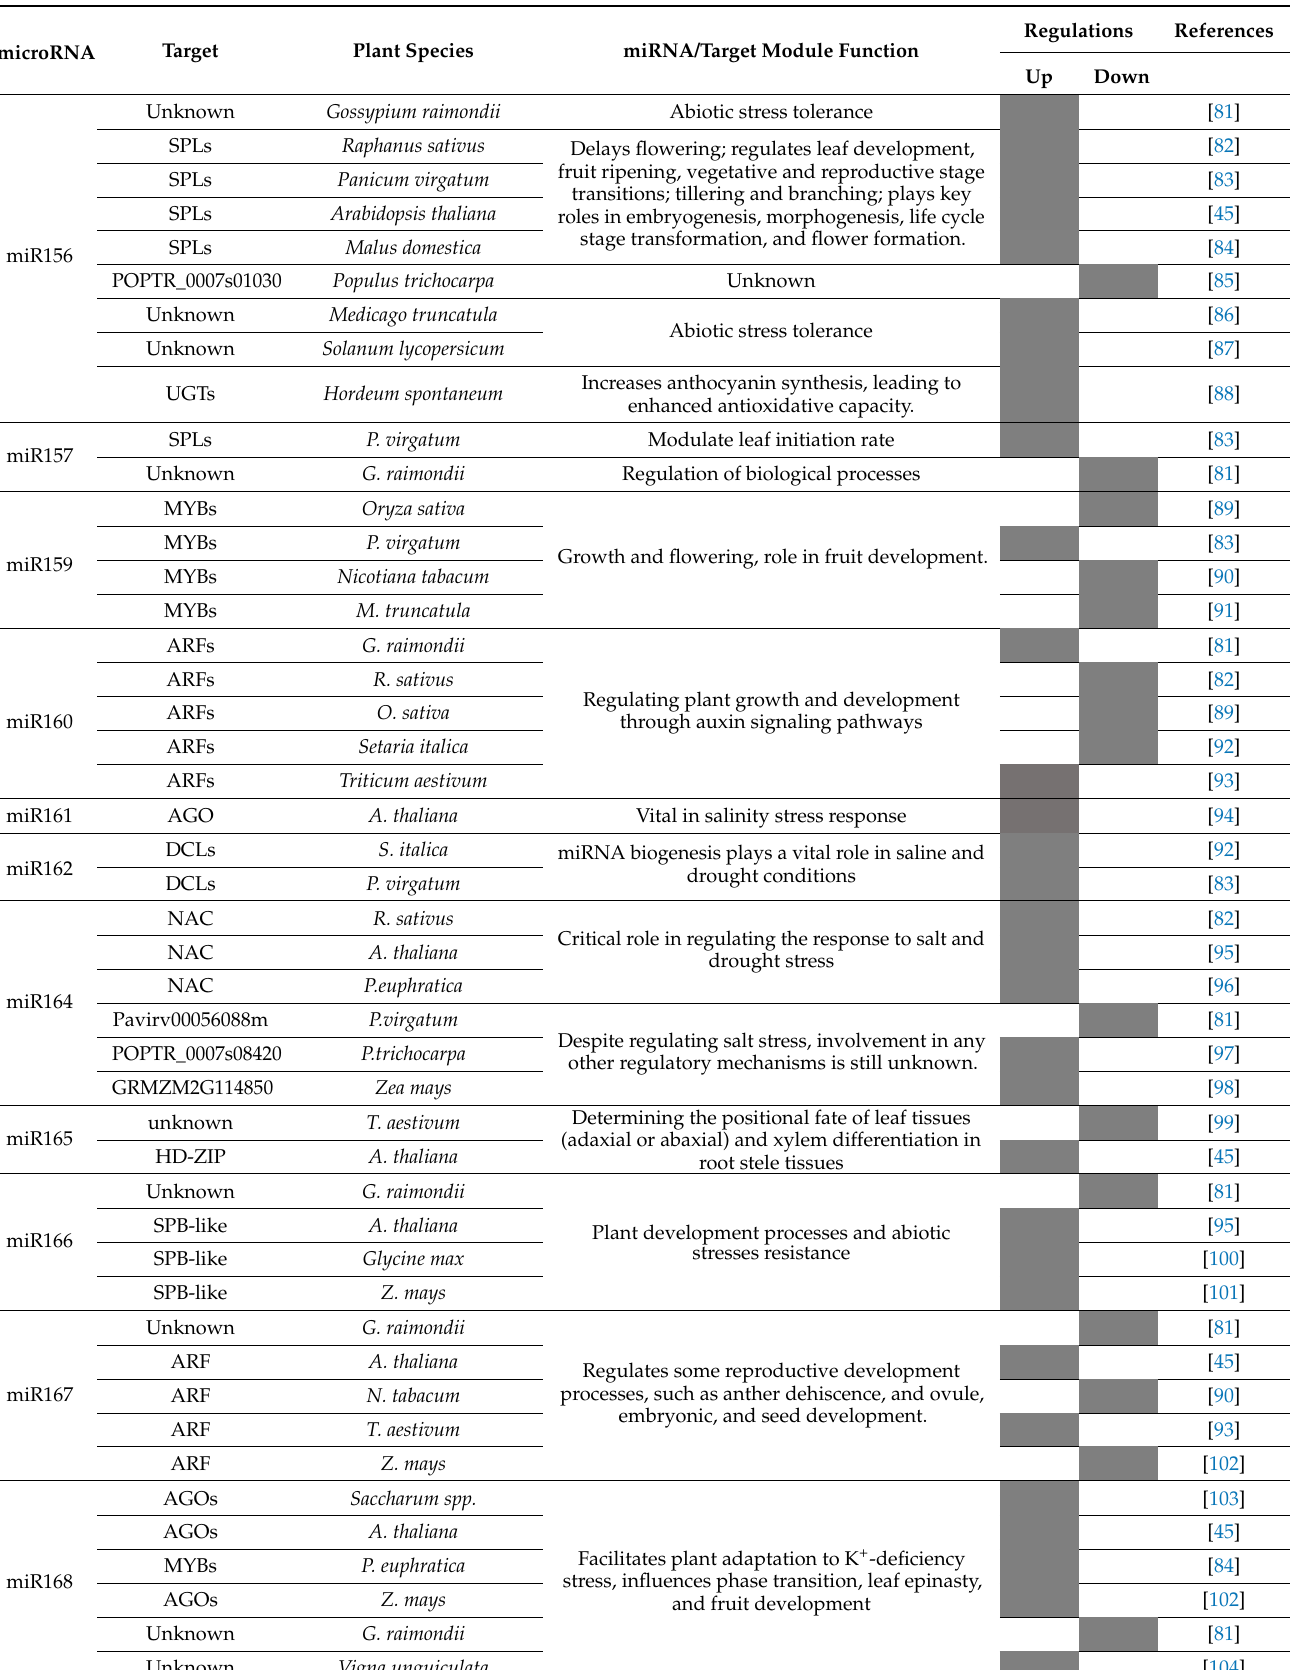
Table 1. Salt-responsive microRNA, their corresponding targets, and regulations in various plant